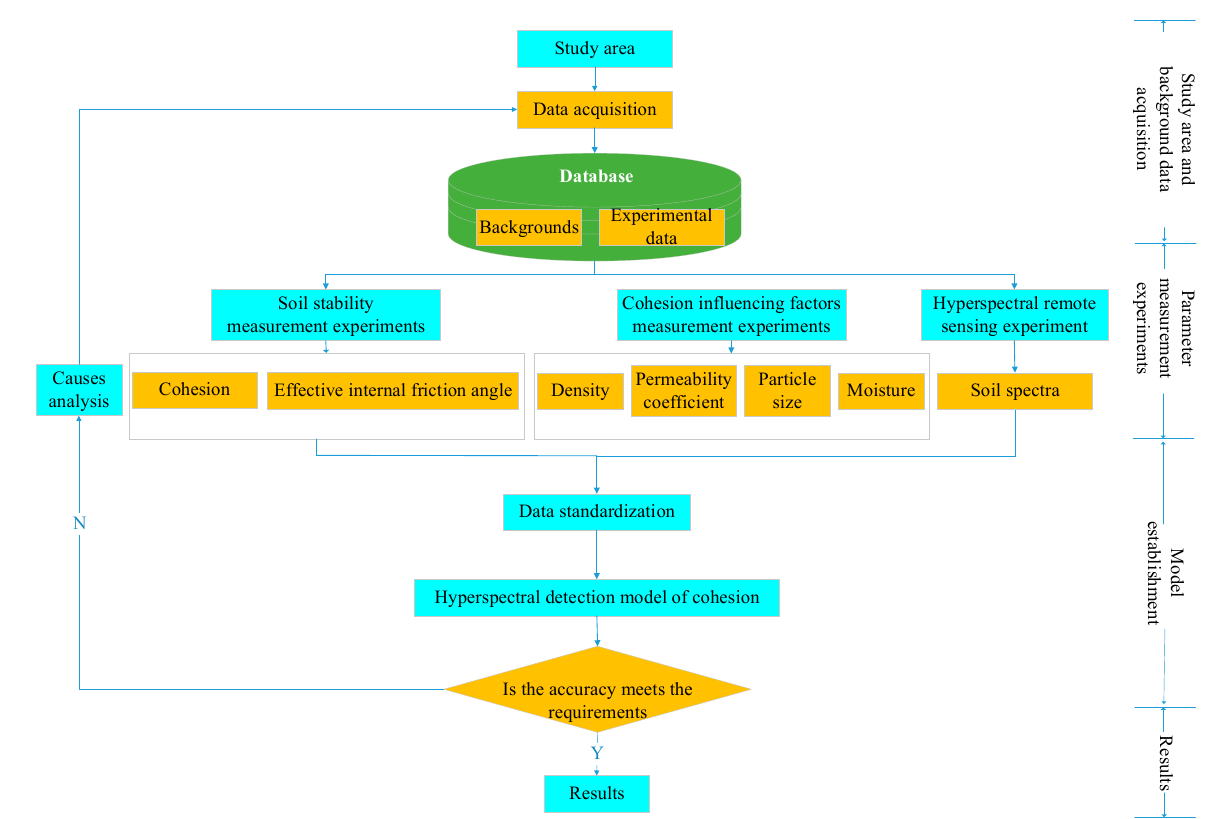
Figure 2. Flowchart of cohesion hyperspectral detection model.